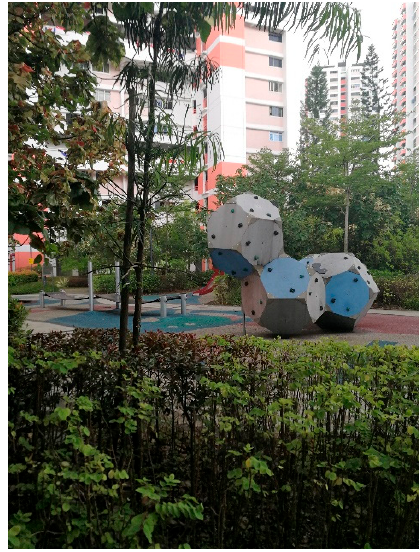
Figure 9. A neighborhood park with greeneries, a playground and exercise facilities.